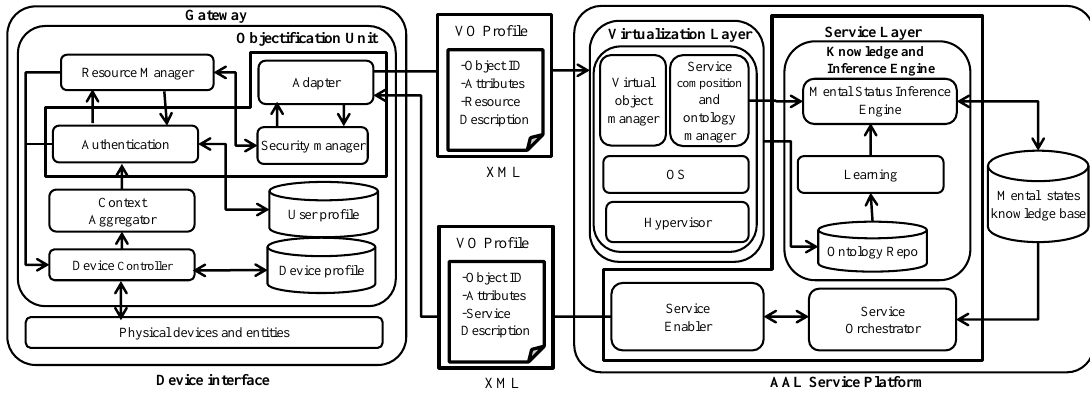
Figure 4. Functional modules of a web of object-based AAL platform especially in a mental healthcare scenario.